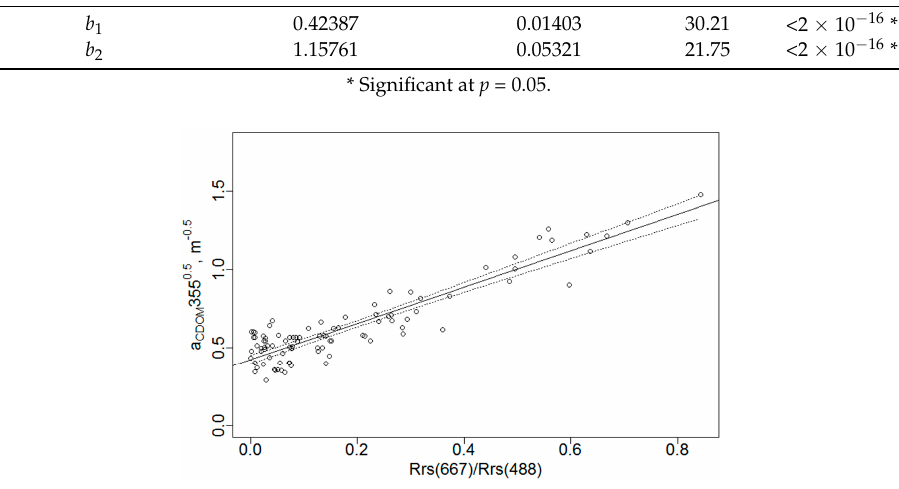
Figure 7. Plot of the in situ a CDOM 355 0.5 values versus the in situ band ratio R rs (667)/ R rs (488) of the test data set. The solid and dashed lines are the OLS fitted Model 2 and the 95% confidence interval, respectively.